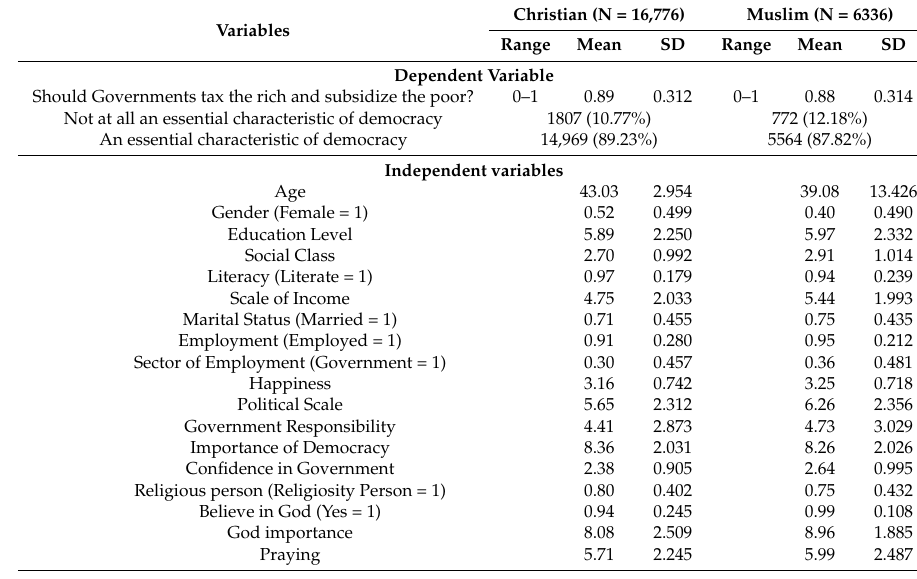
Table 1. Descriptive